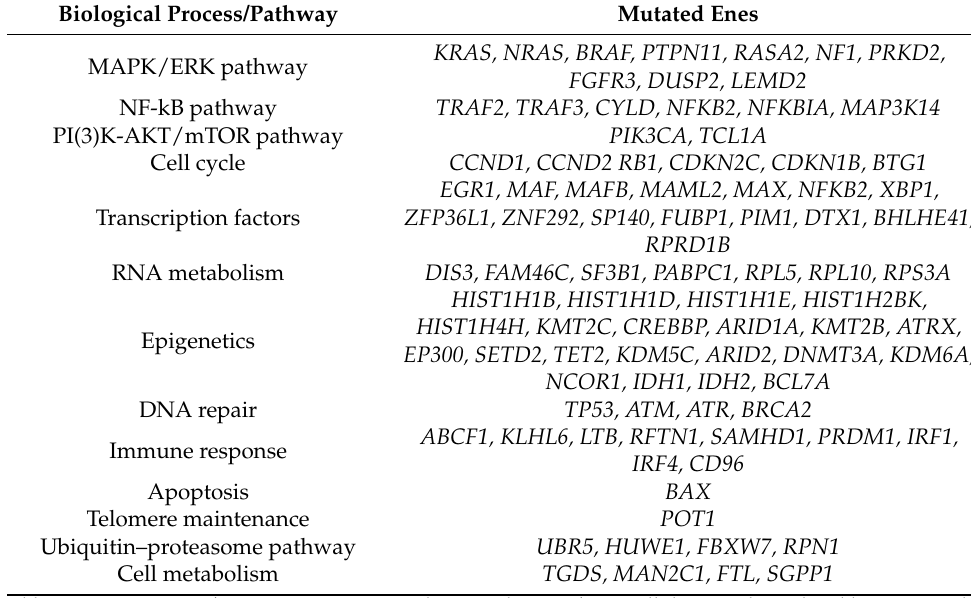
Table 2. The most frequently mutated genes in multiple myeloma (MM)